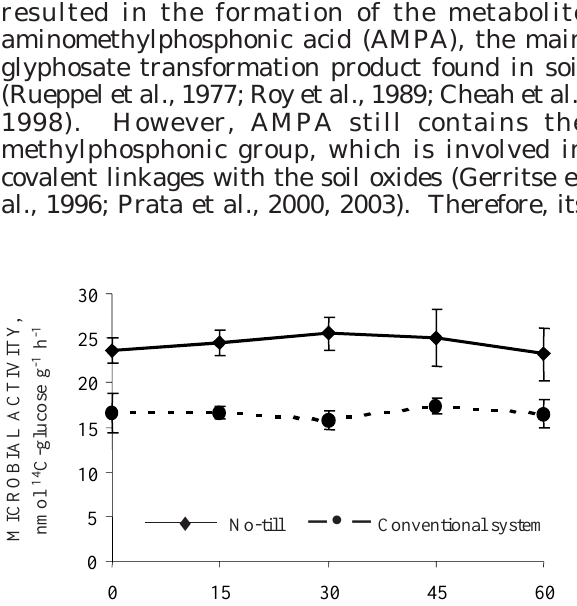
min), dissipation half-life (T dis) and extraction of 1/2 1/2